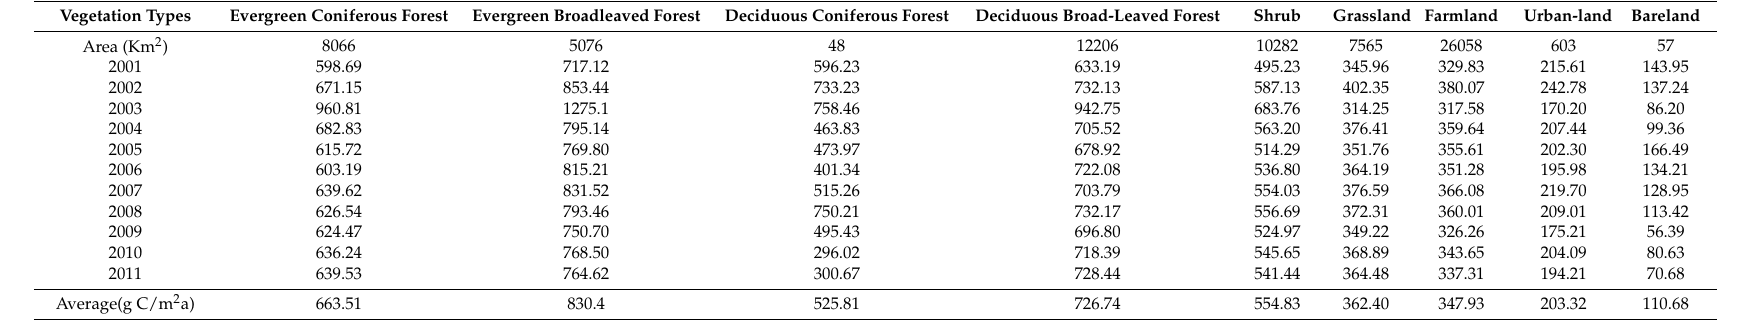
Table 4. The statistics of average NPP in different vegetation